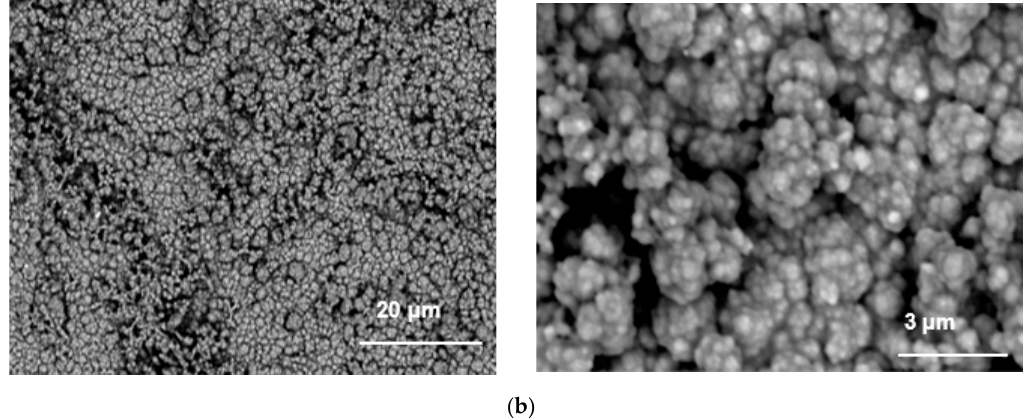
Figure 6. SEM micrographs at different magnifications for PPy-Indo coatings formed on: ( a ) IB and ( b ) ND alloy substrates from ILM-ACN electrolyte containing 0.5 M Py and 0.0175 M Indo at a constant applied potential of 1.1 V/Ag for 600 s.